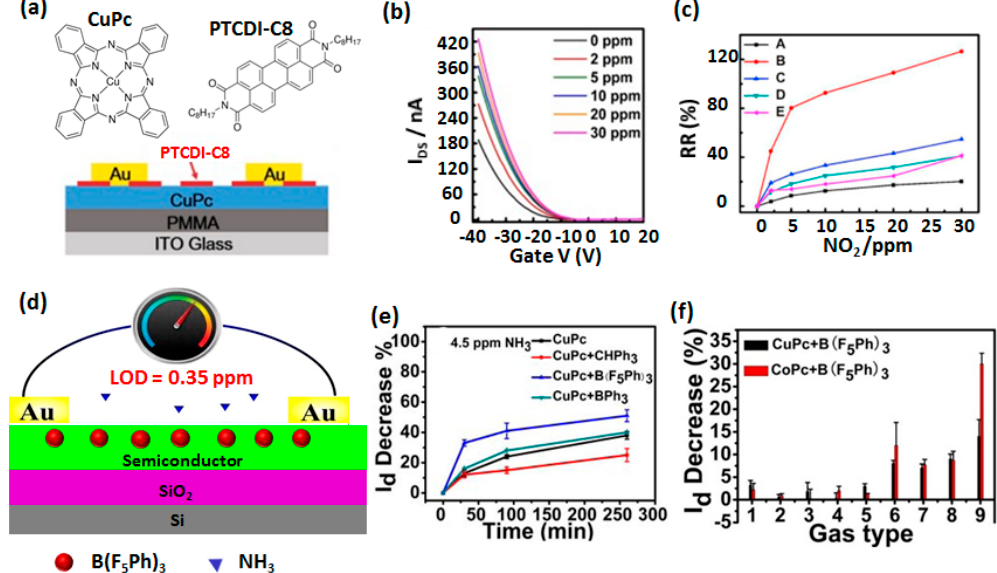
Figure 9. Molecular structure of CuPc and PTCDI-C8 and OFET device design employing CuPc/PTCDI-C8 heterostructure, Au electrode, PMMA dielectric on a ITO substrate ( a ). The